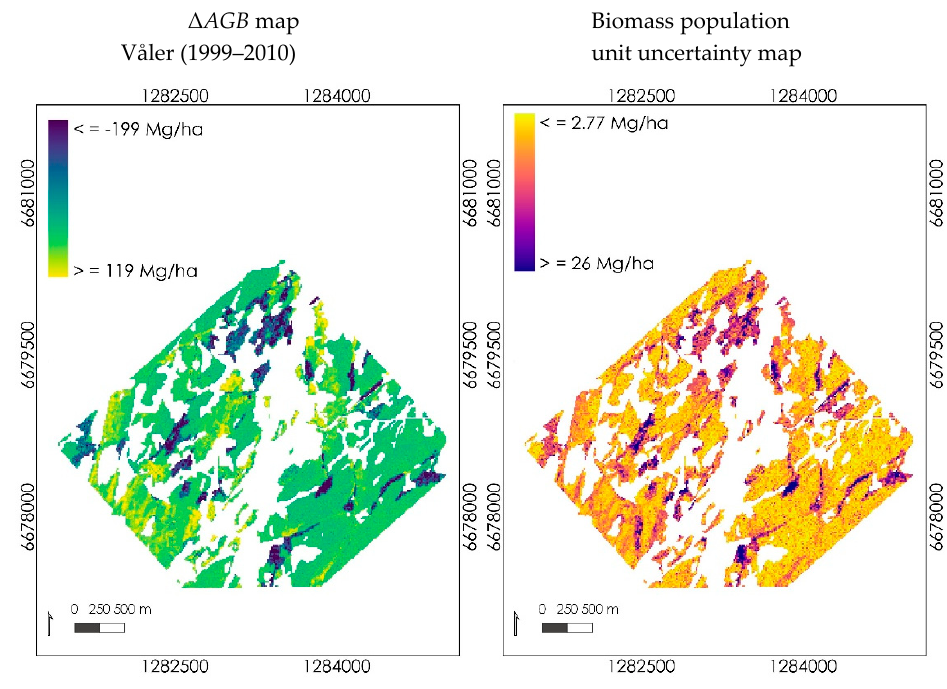
Figure 6. The first column provides wall-to-wall change maps and the second one the corresponding uncertainty map. The upper maps show the La Rioja study area and the lower ones the Våler study area. ETRS89 / UTM zone 30N (N-E) (EPSG: 3042).